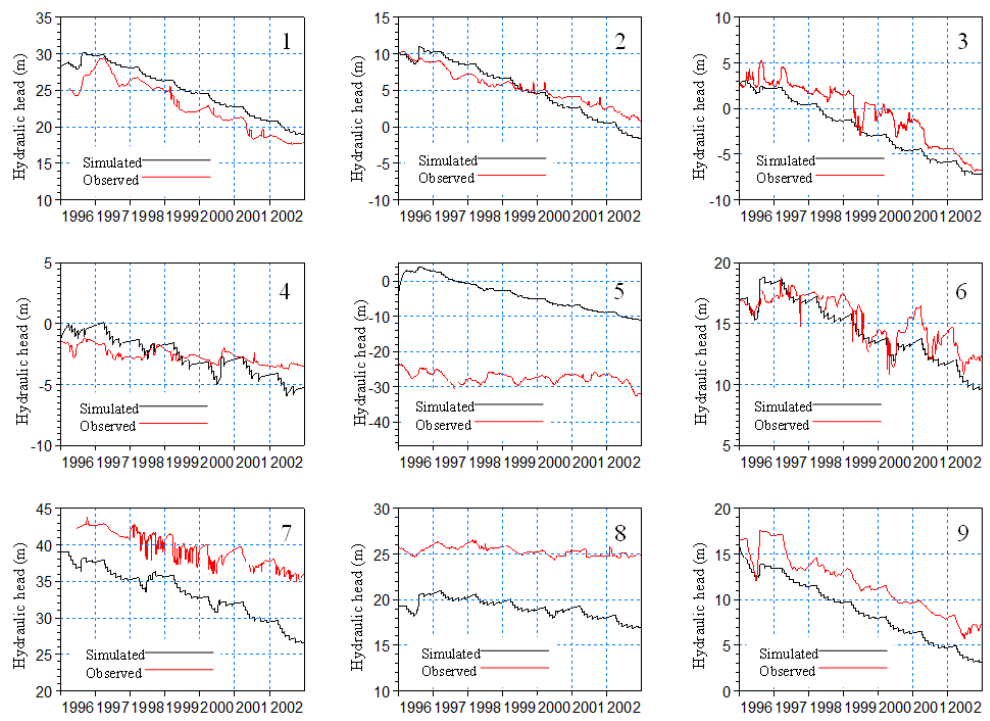
Figure 3. Comparison of observed and simulated hydraulic heads for selected wells (calibration period).